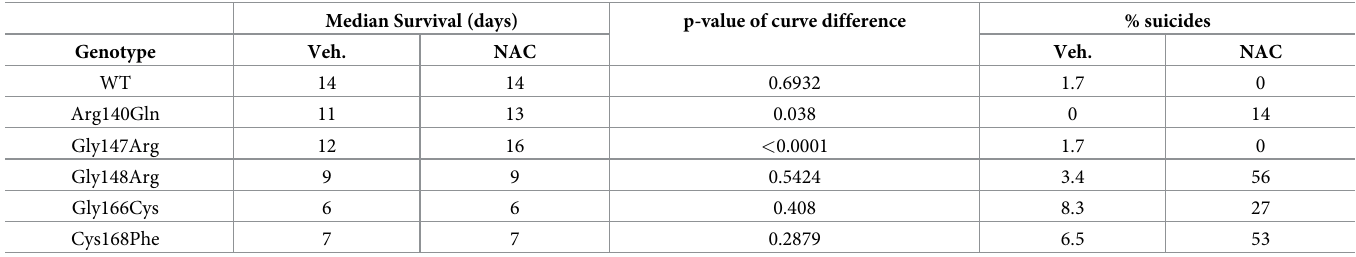
Table 3. Statistical analysis of NAC treatment lifespans. Median survival (days) and p-value of curve difference as calculated by log rank (Mantle-Cox) analysis for each mutant strain with either Veh. (H 2 O) or NAC treatment. % suicides calculated as number of animals that left the plate divided by the total number of animals assayed. NAC: N-acetyl-L-cysteine. Median Survival (days) p-value of curve difference % suicides Genotype Veh. NAC Veh.